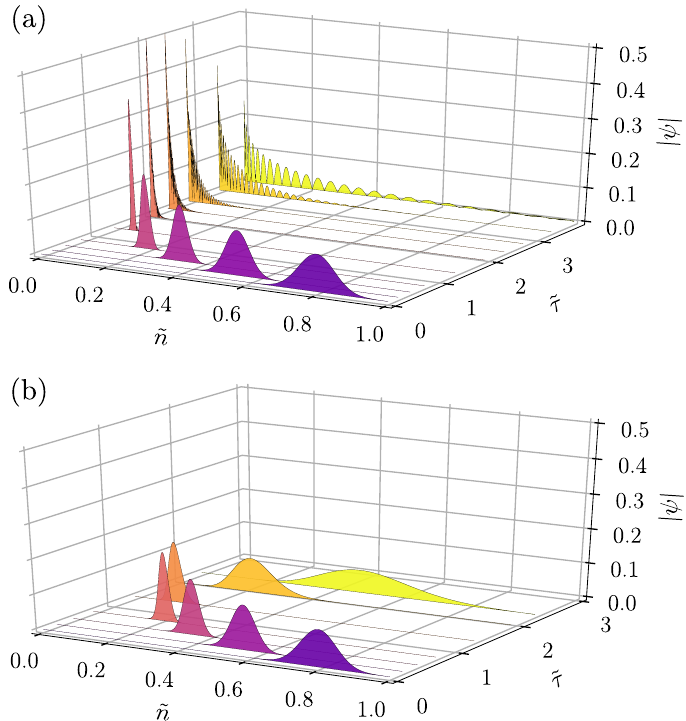
Figure 1: Time evolution of a Gaussian wave packet in the lattice model, with γ = 1, = 0.8, and ˜ w = 0.05 for a lattice of size N = 1001. The initial momenta are ˜ n 0 = − π/ 2 (top) and p = − 0.9 × π/ 2 (bottom). In the first case, the wave packet p 0 0 slows down and localizes at the origin of the lattice, where it disintegrates. In the second case, it is reflected before reaching the